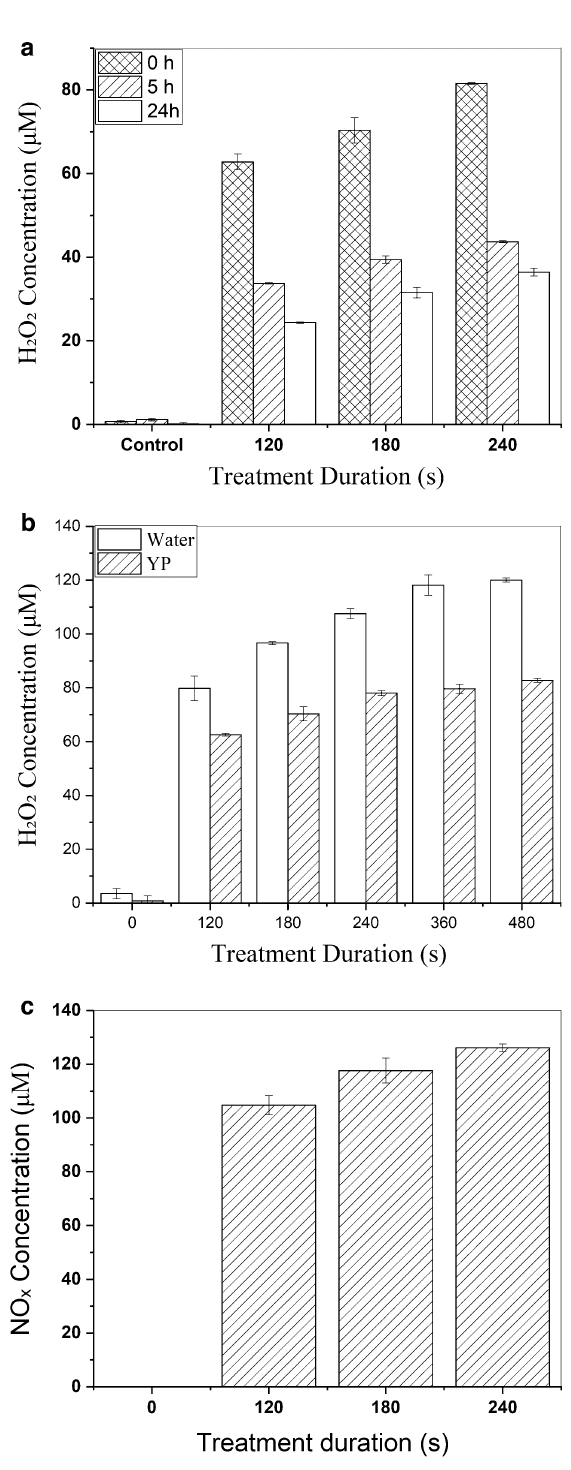
Figure 5. ( a ) Concentration and stability of produced H2O2 in culture media after CAP exposure. ( b ) Concentration of produced H 2 O 2 in YP and distilled water. ( c ) Concentration of produced NO x immediately after CAP exposure. Within five h no more NOx was detectable in the media. The error bars are standard